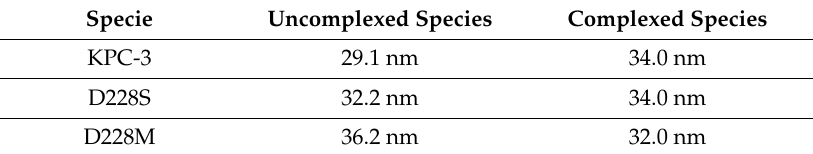
Table 3. Overall Root Mean Square Fluctuation (nm) of the six investigated